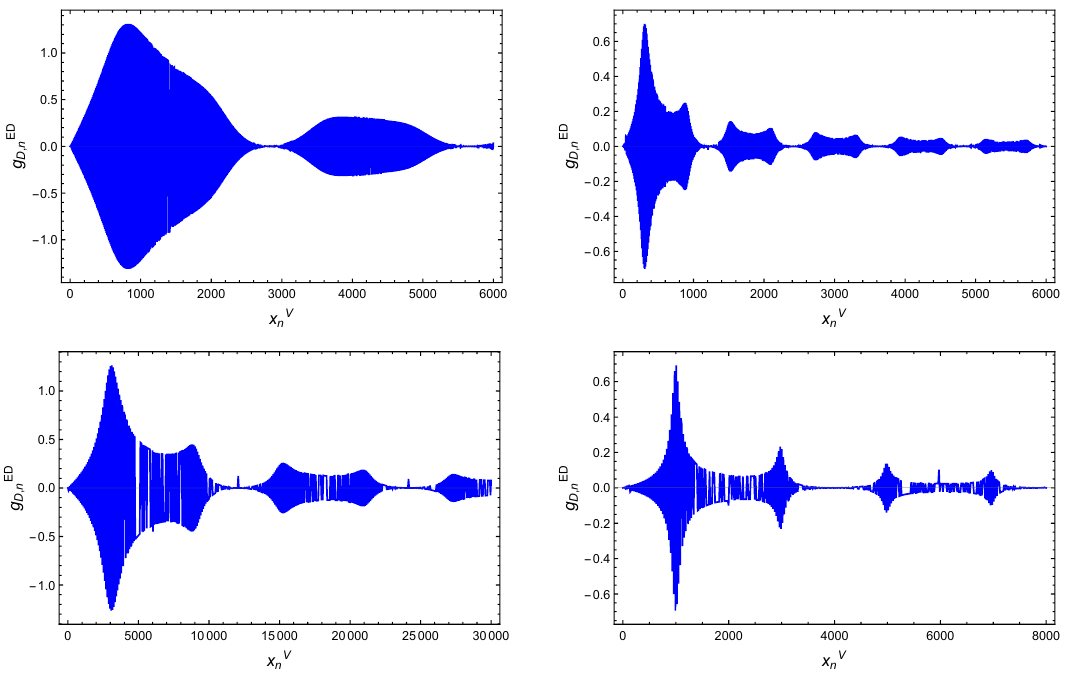
Figure 3 . Gauge couplings as a function of x V the other parameters are the same as (cid:12)gure 2, for BM I (top) and BM III (bottom).